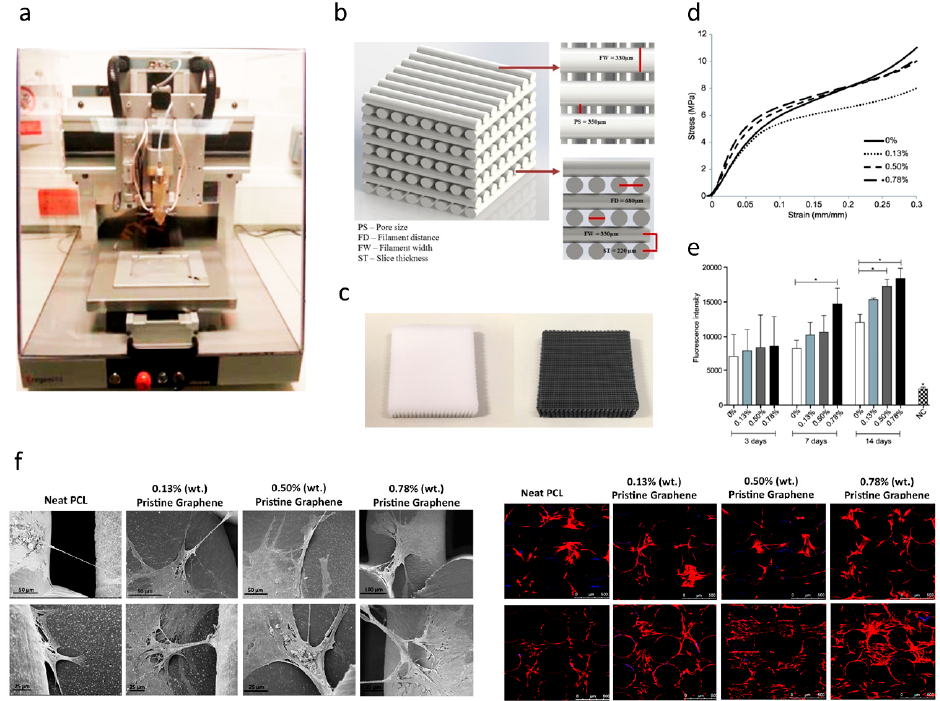
Figure 7. ( a ) Extrusion-based additive manufacturing system; ( b ) design of the PCL and PCL / graphene sca ff olds; ( c ) PCL and PCL / graphene sca ff olds after fabrication; ( d ) mechanical characterization; ( e ) biological characterization (Alamar Blue assay); ( f ) scanning electron microscopy (SEM, left)